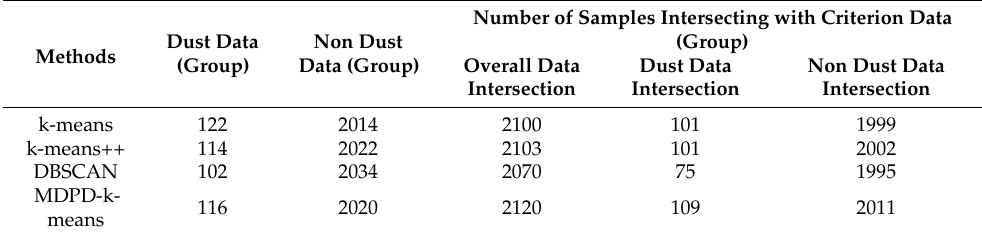
Table 4. Comparison between the recognition results of 4 algorithms and criterion method.